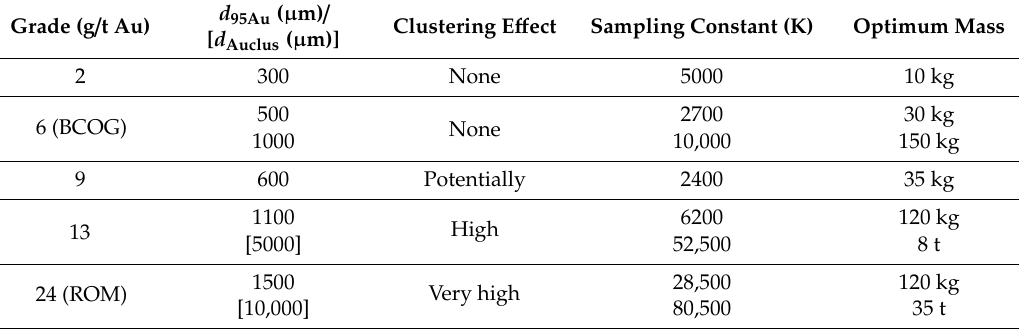
Table 16. Range of theoretical sample mass values for BCOG and ROM